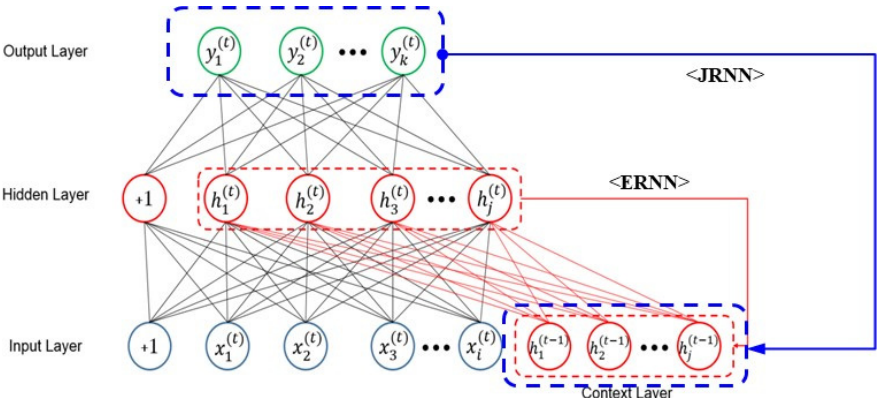
Figure 7. Conceptual diagram of the Elman recurrent neural network (ERNN) and Jordan recurrent neural network (JRNN).